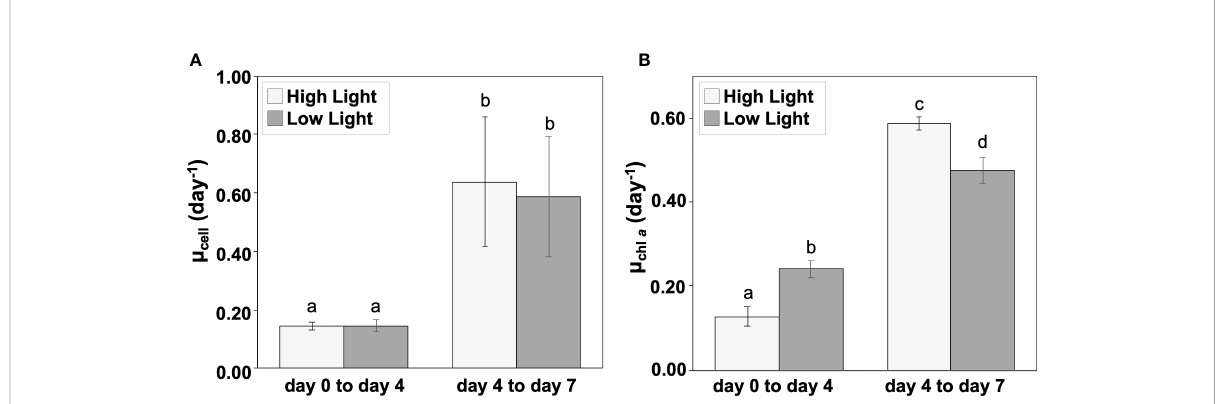
FIGURE 5 Cell-speci fi c (A) and chl a -speci fi c (B) growth rate during the incubation of two periods (day 0 to day 4 and day 4 to day 7). Light gray and gray represent the high (300 µmol photons m -2 s -1 ) and low (30 µmol photons m -2 s -1 ) light conditions, respectively. The alphabets indicate signi fi cant differences among groups (one-way ANOVA and Tukey-Kramer test, p< 0.05). Mean values ( ± SD) indicate the average of three independent measurements.